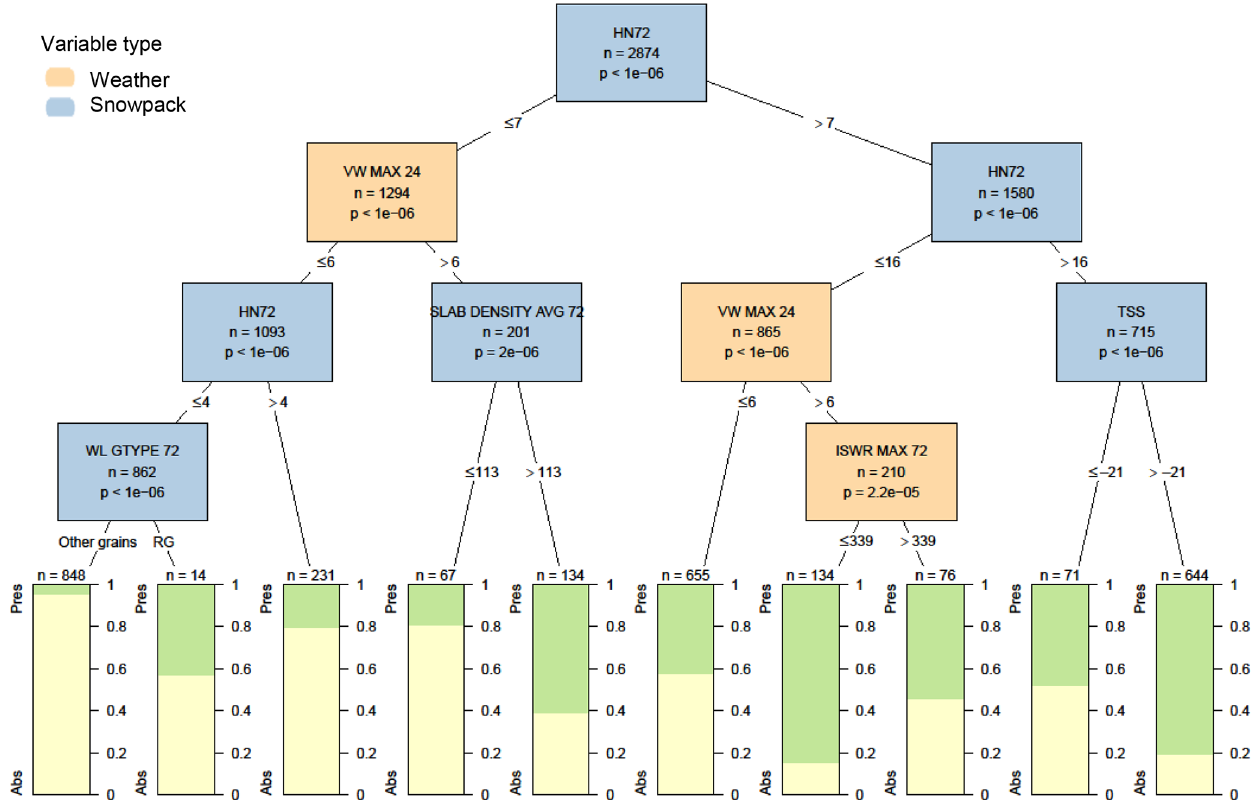
Figure 5. Decision tree for the presence or absence (Pres/Abs) of storm slab avalanche problems based on weather and snowpack variables. Variables appearing in the tree include the height of snow in the past 72h incm (HN72), the maximum hourly wind speed over the past 24h in ms − 1 (VW MAX 24), the grain type beneath snow deposited in the past 72h (WL GTYPE 72), the average density of all snow deposited in the past 24h in kgm − 3 (SLAB DENSITY AVG 72), the maximum intensity of incoming shortwave radiation in the past 72h in MJm − 2 (ISWR MAX 72), and the snow surface temperature in ◦ C (TSS). Terminal nodes show the proportion of cases with storm slab problems present (green) and absent (yellow).